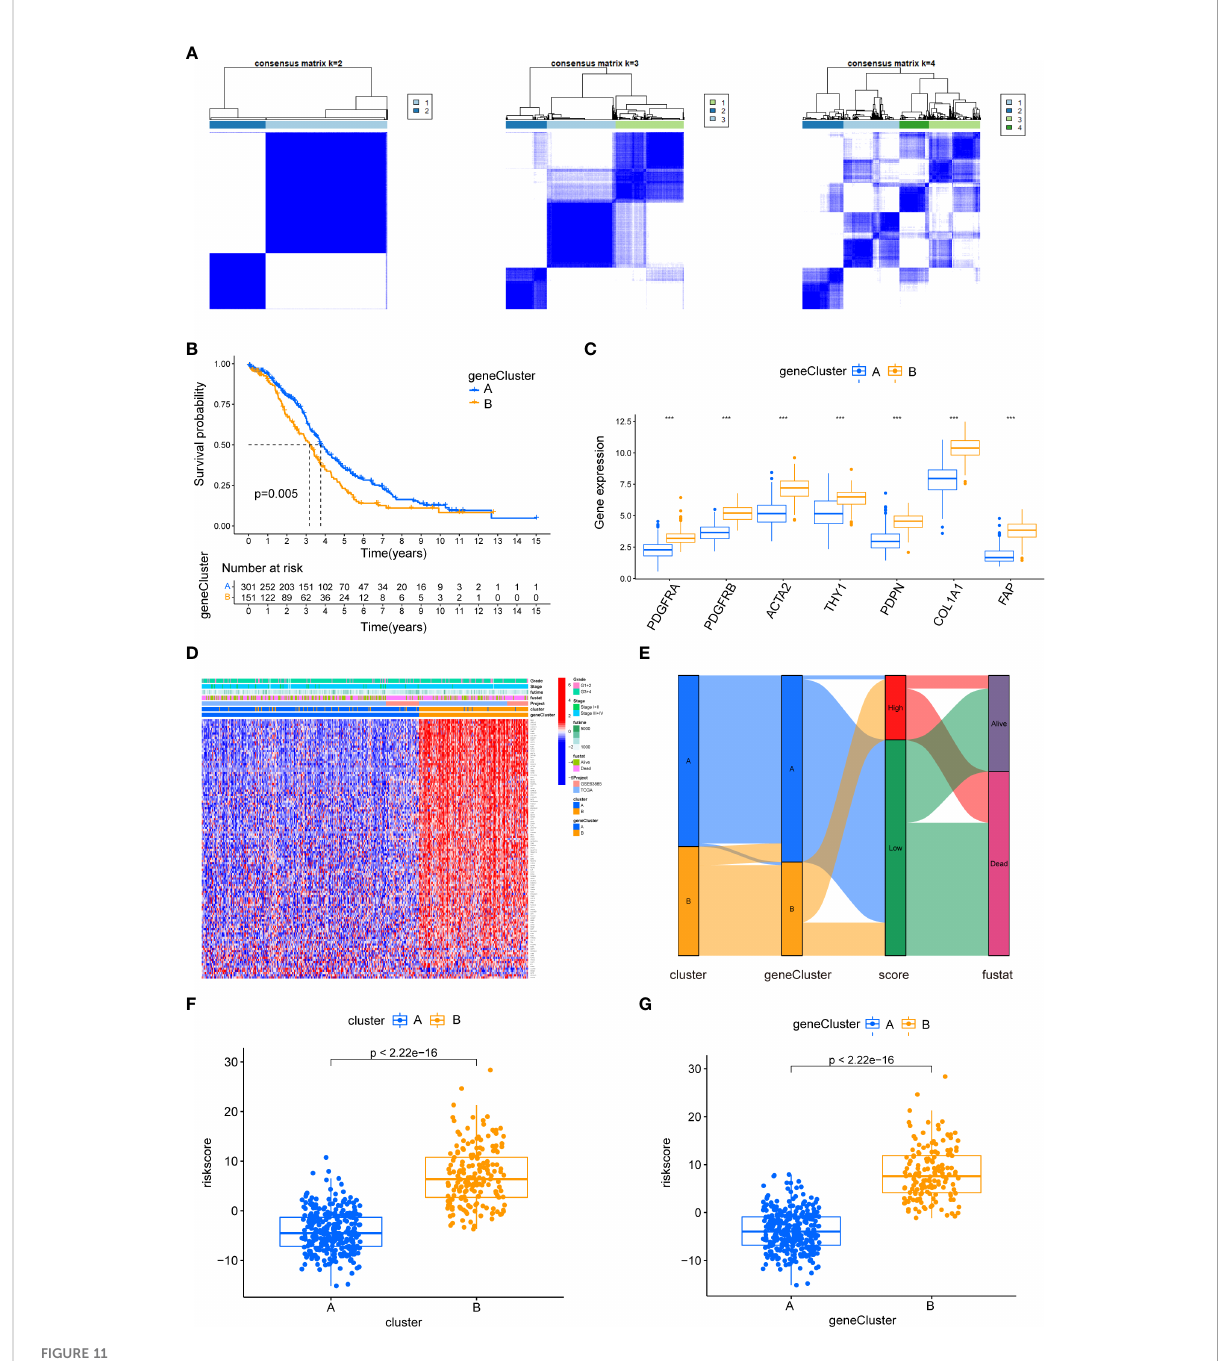
FIGURE 11 The biological characteristics of CAF gene cluster and construction of CAF riskscore system. (A) Two gene clusters (k = 2) were identi fi ed by consistent clustering based on prognostic DEGs. (B) Kaplan – Meier curves of overall survival between gene clusters A and B. (C) Differences in the expression of seven CAF markers among the two gene clusters. (D) The heat map was drawn to visualize the expression of prognostic DEGs in distinct CAF clusters and gene clusters. (E) Sankey diagram illustrating the distribution of survival outcomes among the distinct clusters, gene clusters, and CAF riskscore groups. (F) Differences in CAF riskscore among two clusters in EOC cohorts. (G) Differences in CAF riskscore among two gene clusters in EOC